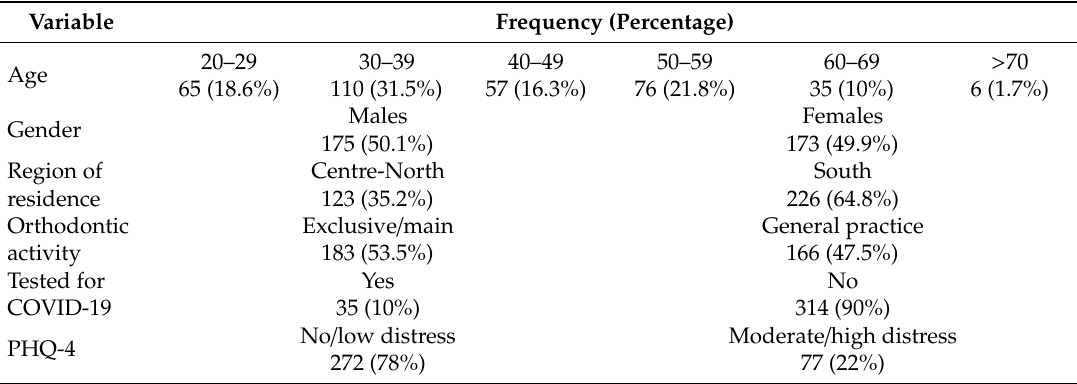
Table 1. General data of the